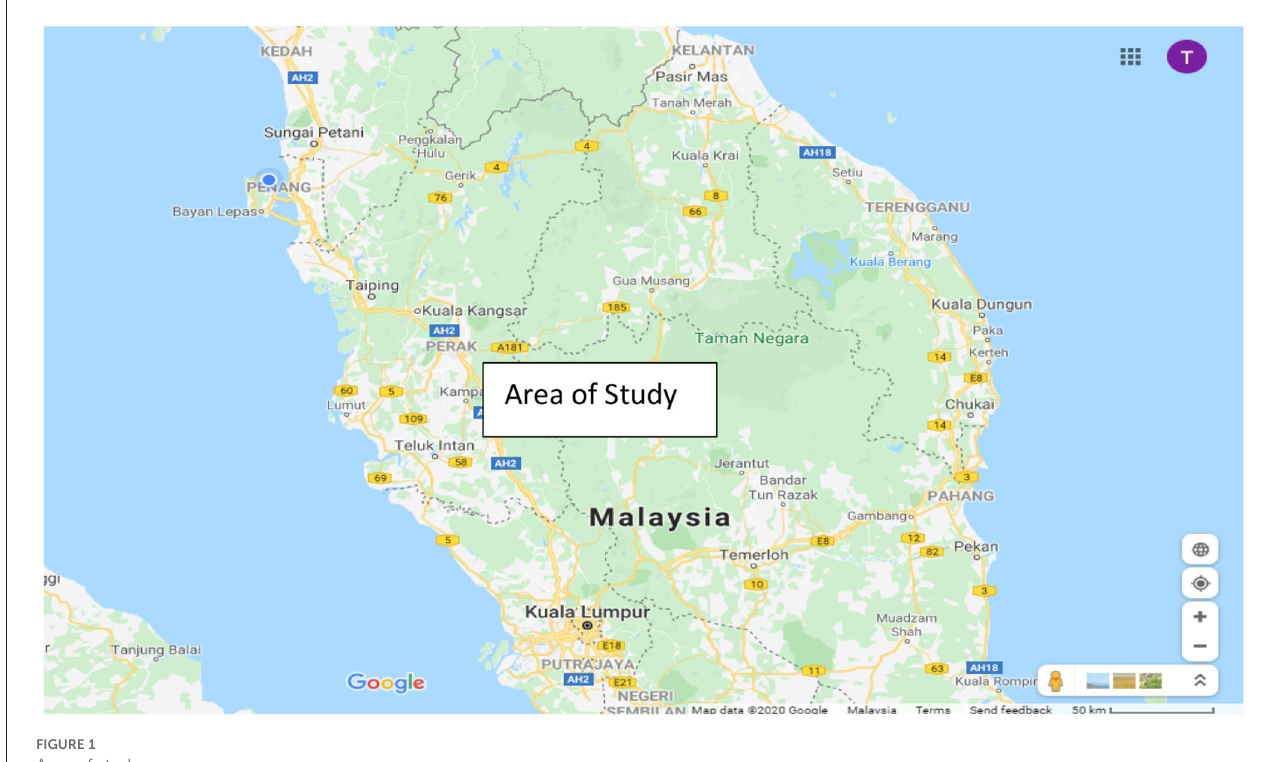
FIGURE1 Area of